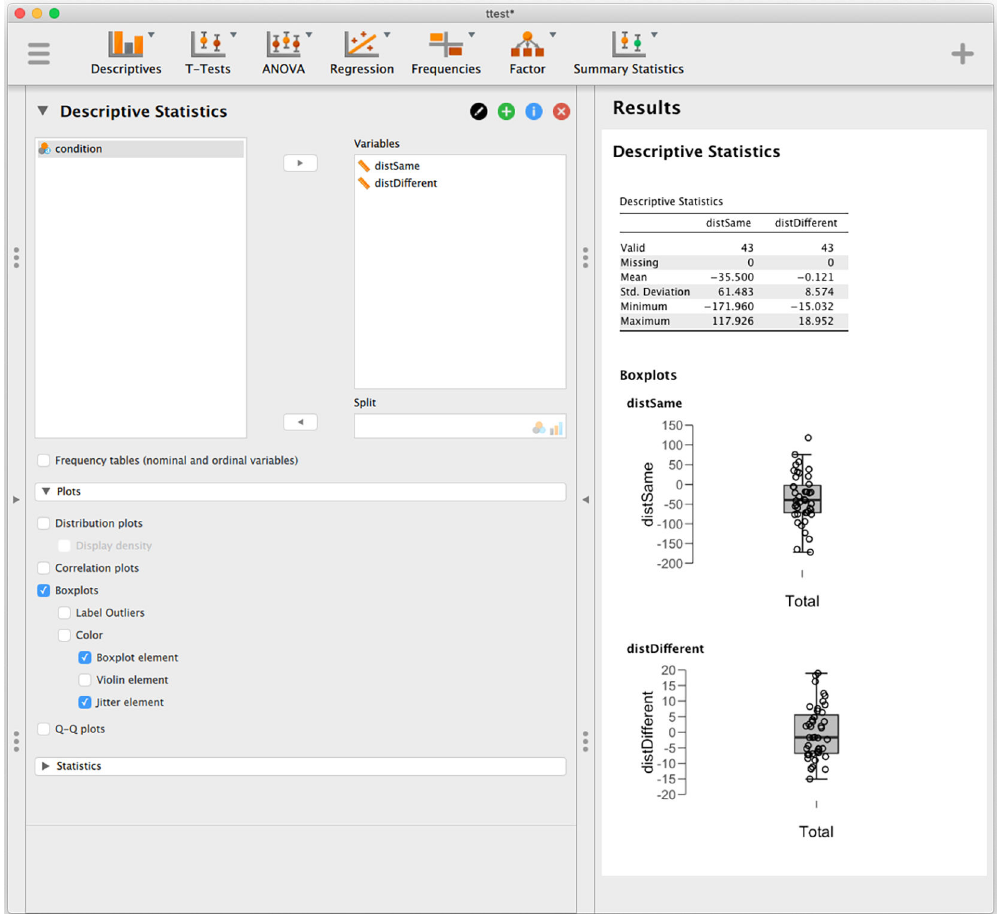
Figure 2. JASP screenshot showing descriptive statistics, including mean and standard deviation, and boxplots for the distSame and distDifferent